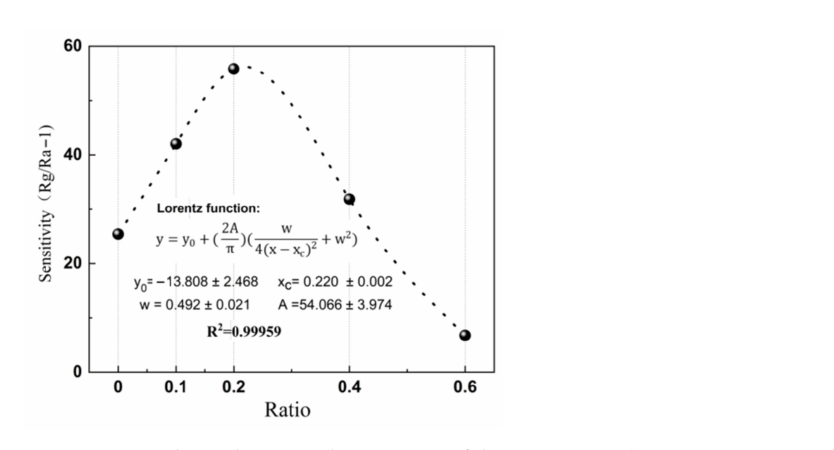
Figure 7. Correlation between the response of the ZnO-x rGO (x = 0, 0.1, 0.2, 0.4, 0.6) sensor and